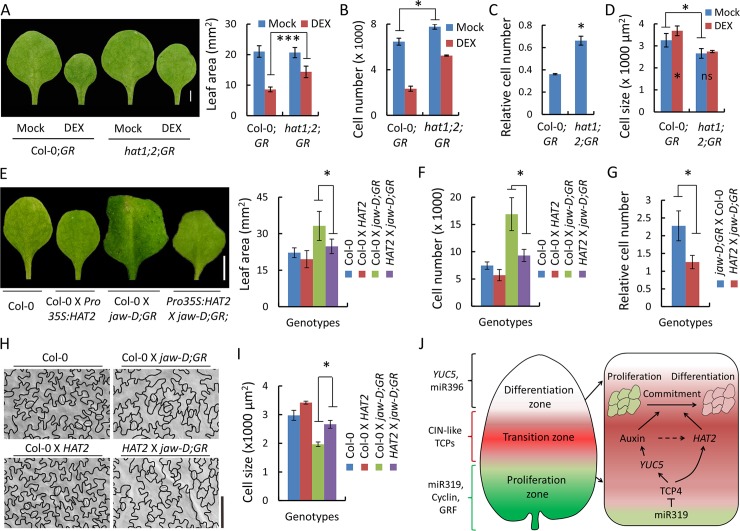
TCP4 requires the HD-ZIP II transcription factors for leaf maturation.(A) to (D) Mature first leaves (A, left) of plants grown without (Mock) or with (DEX) 12 μM dexamethasone, their average area (A, right), total number of pavement cells (B), cell number upon TCP4 induction relative to mock-induction (C) and average abaxial pavement cell area (D). Sample number, 10–13 leaves. Col-0;GR and hat1;2;GR indicate Col-0;ProTCP4:mTCP4:GR and hat1;2;ProTCP4:mTCP4:GR, respectively. For (A), *** indicates p <0.0001 (Unpaired Student’s t-test was performed). (E) to (I) Mature first leaves from 29-day old seedlings of indicated genotypes (E, left), their average area (E, right), total pavement cell number (F), cell number relative to Col-0 (G), outline of abaxial pavement cells (H) and their average area (I). N, 8–12 leaves. jaw-D;GR and HAT2 indicate jaw-D;ProTCP4:mTCP4:GR and Pro35S:HAT2, respectively. For (D) and (I) total 125–150 cells per leaf were measured and averages from 3–7 leaves are shown. Error bars indicate SD. * indicates p <0.05. Unpaired Student’s t-test was used. (J) A schematic diagram proposed to describe the mechanism of TCP4-induced commitment to differentiation of proliferating cells in a wild type leaf. The proliferative basal zone (green) remains devoid of TCP4 activity due to the action of miR319 and expresses cyclins and GRF [22,65]. The transition zone (red) above the base expresses miR319-regulated class II TCP proteins that induce cell commitment within this region via auxin response as well as HAT2 activation. TCP4 activity declines in the differentiated zone towards the tip (white), which expresses the direct targets of TCP4 such as YUC5 and miR396 [22,27]. Scale bars, 2 mm (A), 5 mm (E) and 100 μm (H).